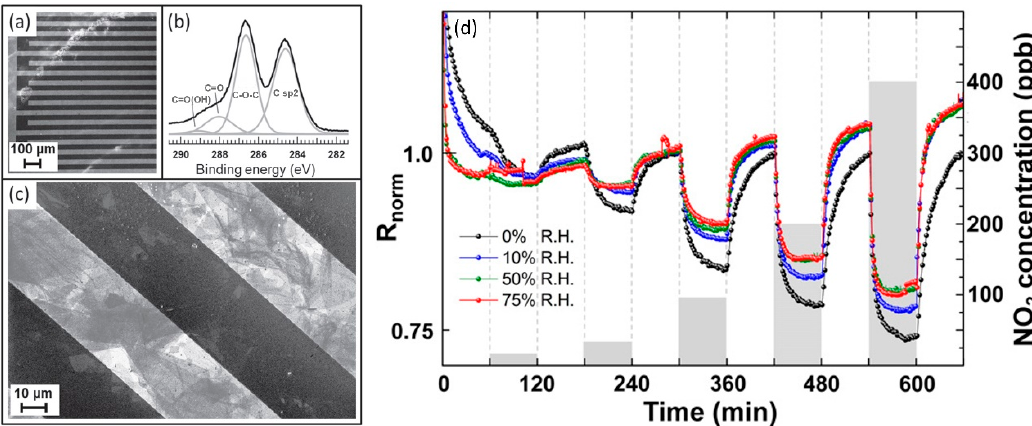
Figure 8. Panel ( a ): SEM image of the device. The lighter stripes are the Pt interdigitated electrodes on Si 3 N 4 substrate; Panel ( b ): XPS C 1s core level spectrum of the deposited GO flakes. The grey lines are the fitting curves, labelled with their own relative C chemical bond (adapted with permission from [80]. Copyright 2013 American Chemical Society, Washington, DC, USA); Panel ( c ): SEM image of the device at higher magnification than ( a ); Panel ( d ): normalized resistance of a GO-based conductometric gas sensor exposed to various NO 2 concentrations (ranging from 20 to 400 ppb) at different RH (adapted with permission from [81], © IOP Publishing, Bristol, United Kingdom. Reproduced with all permission. All rights reserved.).